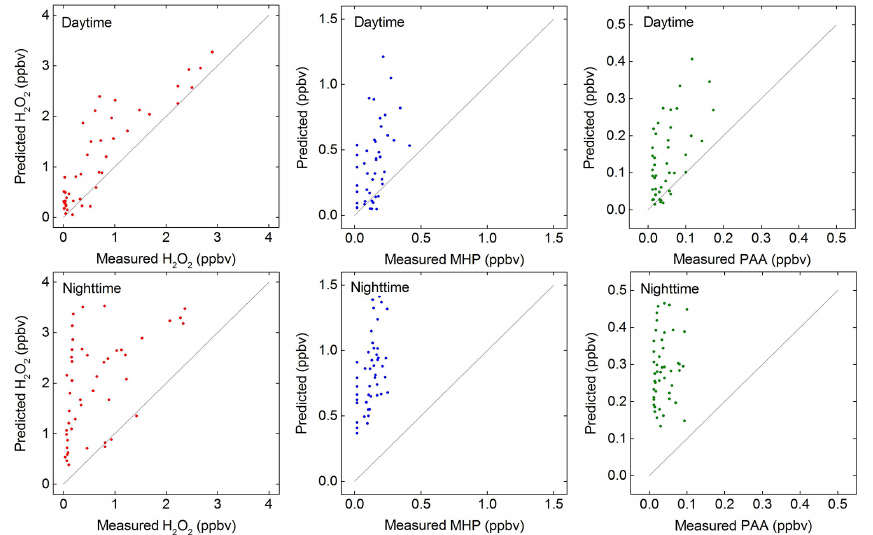
Figure 4. Comparisons between measured and predicted concentrations of atmospheric peroxides in the model base case for daytime and nighttime during the Phase I (8–11 June). The solid lines represent the 1:1 ratio of observed to modeled